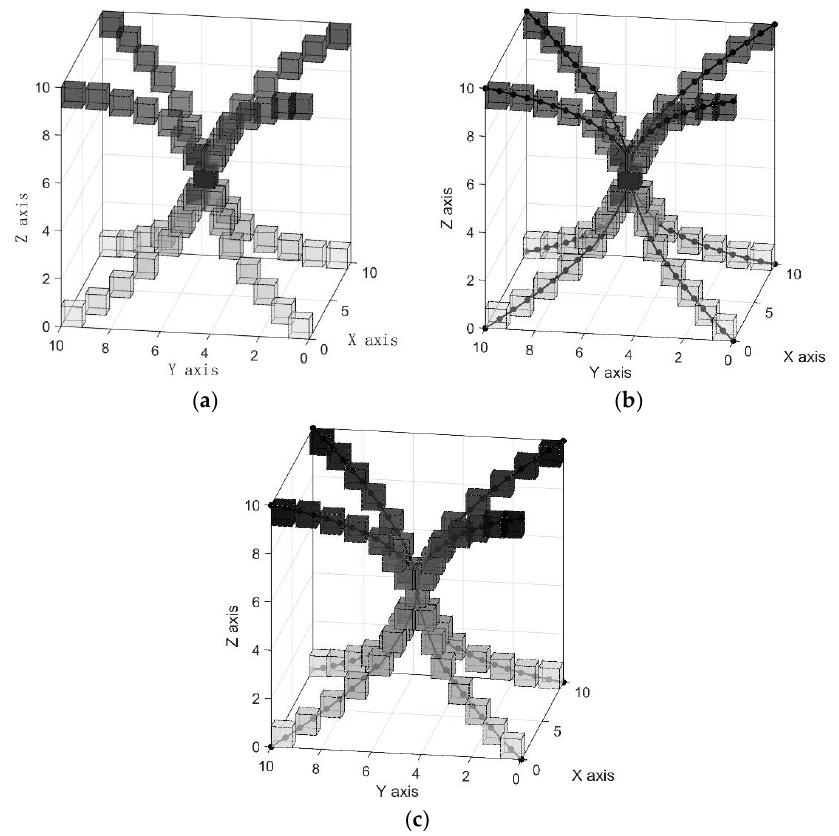
Figure 3. Time Density of four simulated trajectories. ( a ) The TotalTimeDensity of the simulated trajectories; ( b ) the TotalTimeDensity volume stacked with the simulated trajectory; and ( c ) AverageTimeDensity volume—the resulting density volume obtained by normalizing the TotalTimeDensity volume by the number of trajectories.